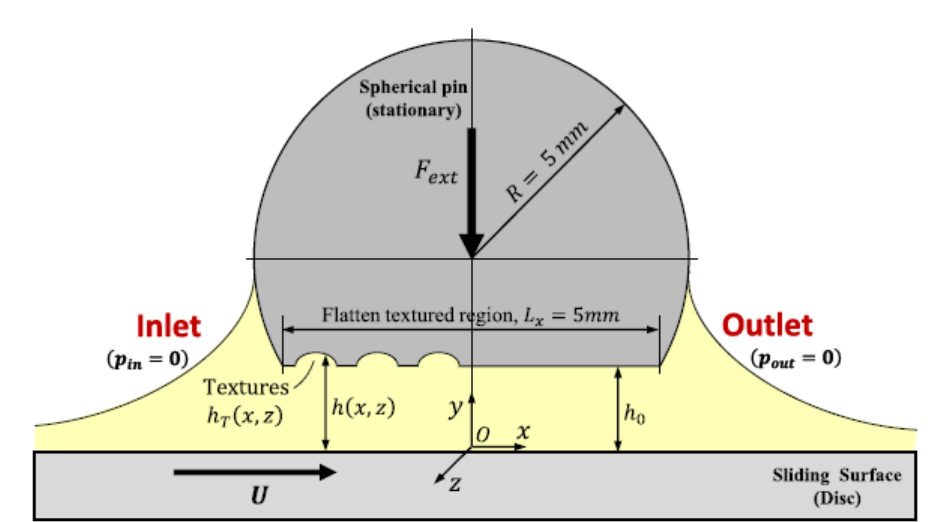
Figure 7. Schematic of the pin-on-disc experimental setup illustrating the textured interface and the main variables used in the numerical